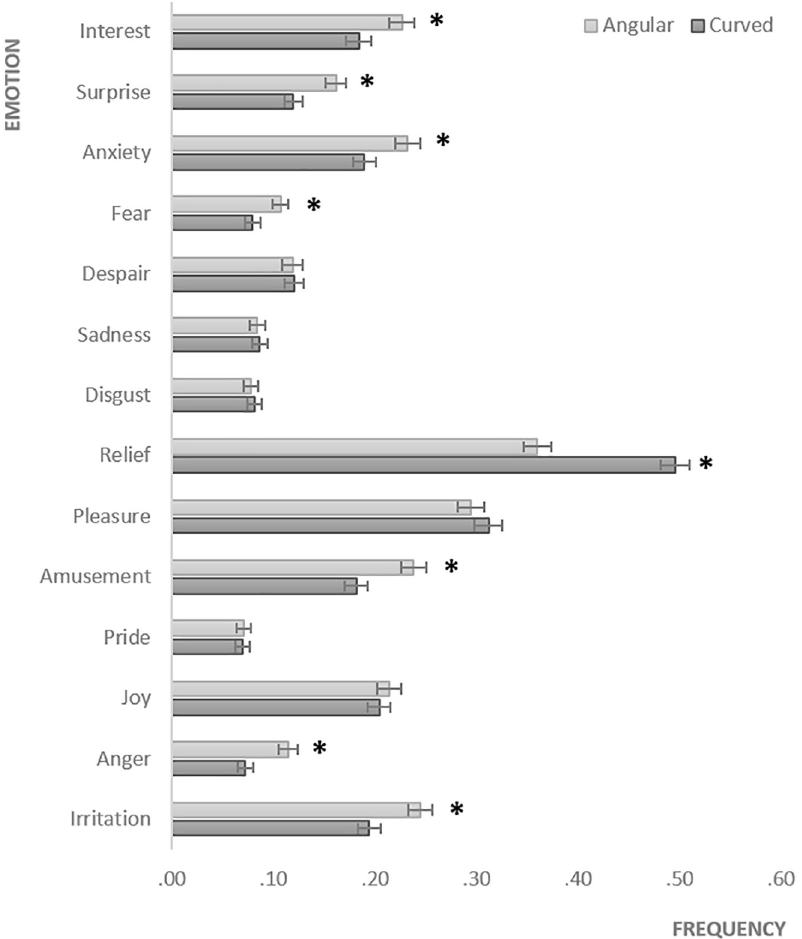
Fig 11. Angular vs. curved pills’ emotional associations. The bars represent SE. � Significant (p < .05) differences between angular and curved pills’ associations.